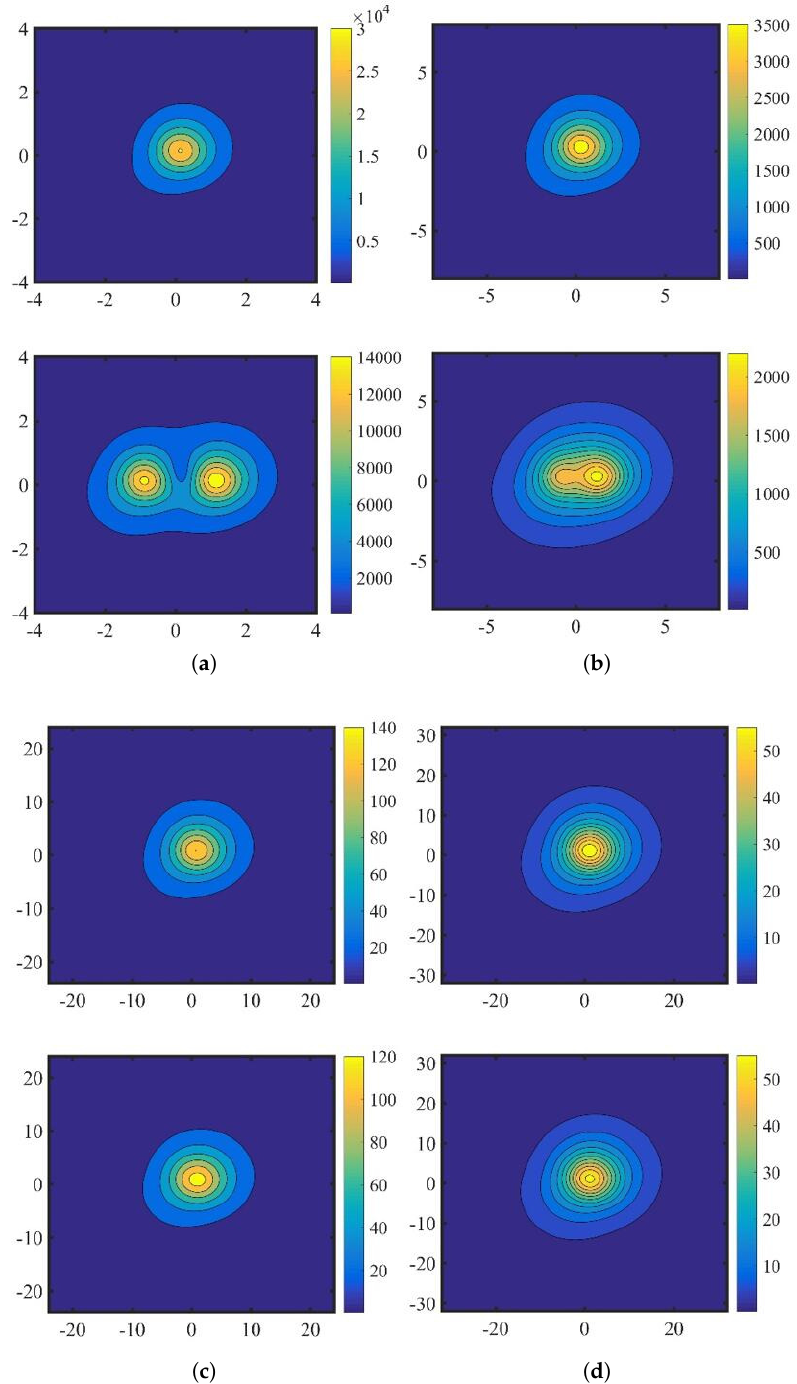
Figure 6. The total magnetic field distributions of two magnetic dipoles and a single magnetic dipole under different spatial scales (the upper picture shows the total magnetic field distribution of a single magnetic dipole, and the lower picture shows the total magnetic field distribution of two magnetic dipoles). ( a ) Spatial scale is 0.5; ( b ) Spatial scale is 1; ( c ) Spatial scale is 3; ( d ) Spatial scale is